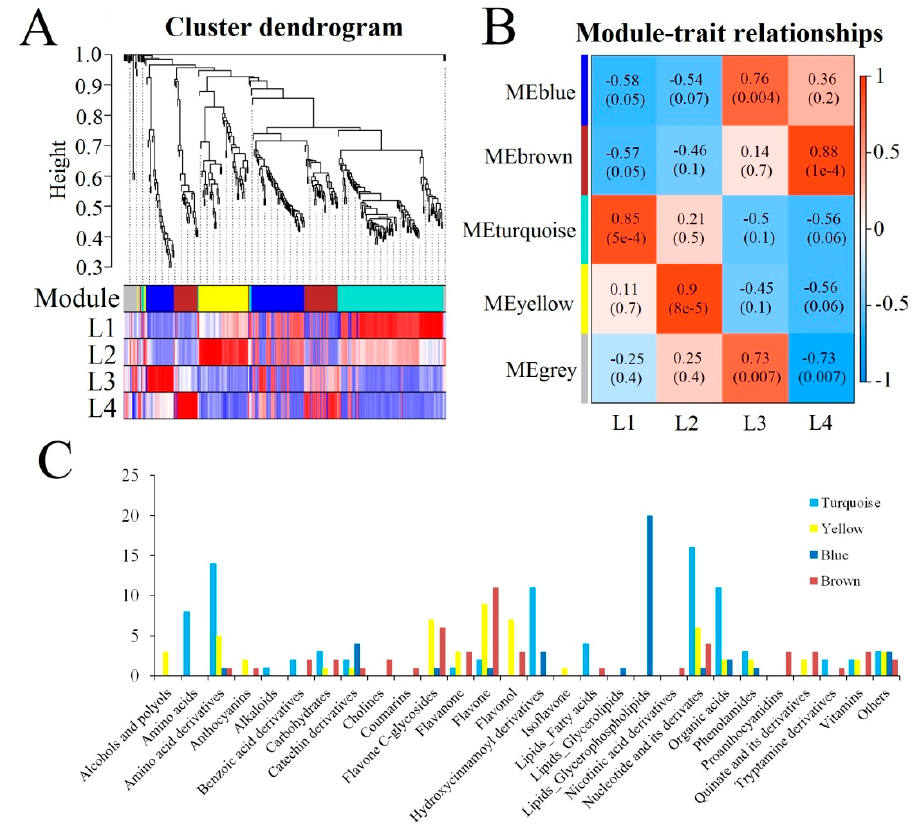
Figure 5. Weighted correlation network analysis (WGCNA) of all identified metabolites. ( A ) Cluster dendrogram of metabolites based on metabolome levels in the four growth stages. Each branch in the tree represents one metabolite, and different colours represent different metabolome co-expression modules. ( B ) Module–group association. Each row represents an expression module, while each column corresponds to a sample group. The colour of each cell at the row-column intersection indicates the correlation coefficient between the module and group. The colour bar indicates the degree of correlation from low (blue) to high (red). ( C ) Distribution of metabolites in different WGCNA modules.